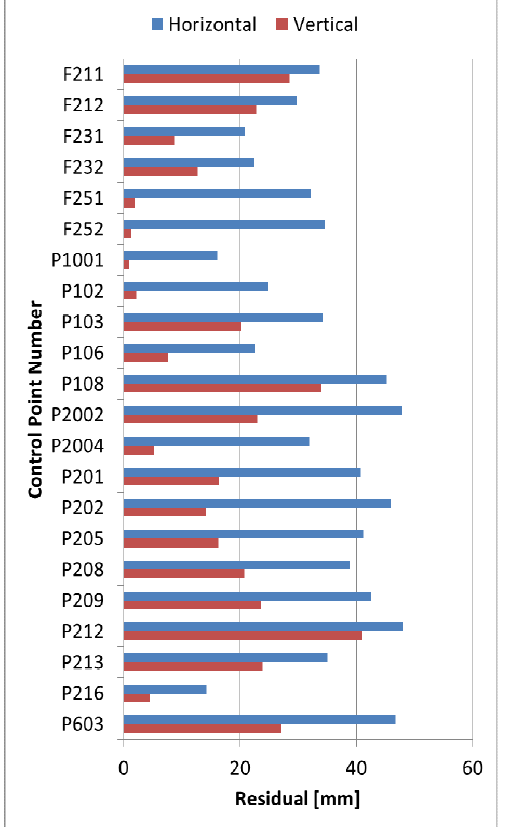
Figure 4. Residuals calculated from comparing aligned and georeferenced ILRIS-LR data to a control field.